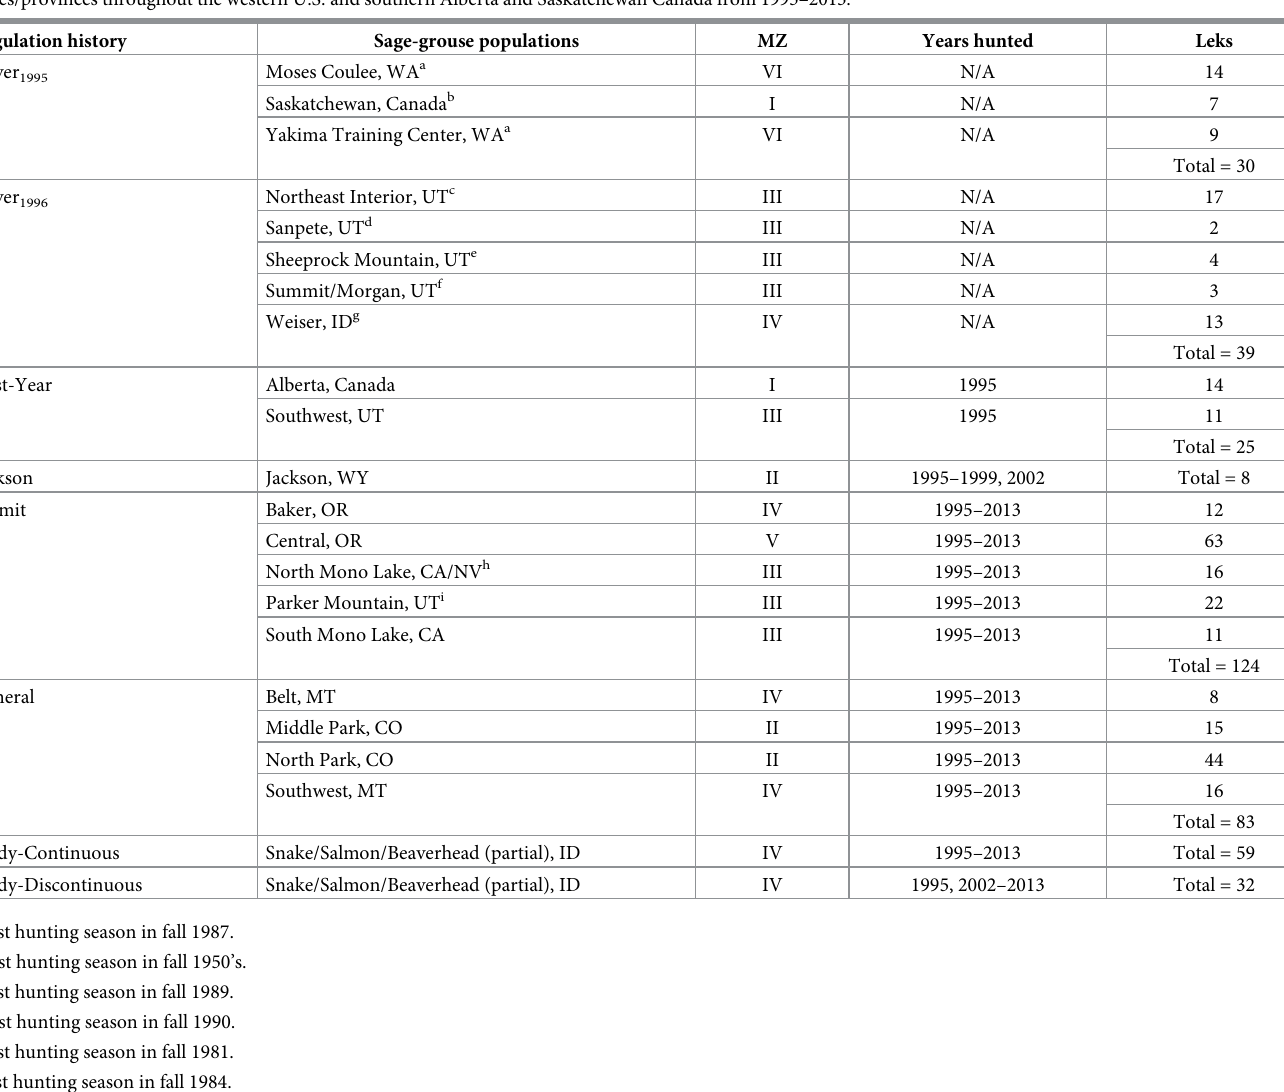
Table 1. Descriptions of sage-grouse populations, Western Association of Fish and Wildlife Agencies Management Zones (MZ), years hunted, and lek sample sizes used in N-mixture models. Regulation histories were stratified by sage-grouse populations with the same years when human harvest of sage-grouse occurred ( n = 8 regu- lation histories). The ‘Never’ regulation history was subdivided into SG populations with adequate data for 1995–2013 and 1996–2013. Male count data were collected by states/provinces throughout the western U.S. and southern Alberta and Saskatchewan Canada from